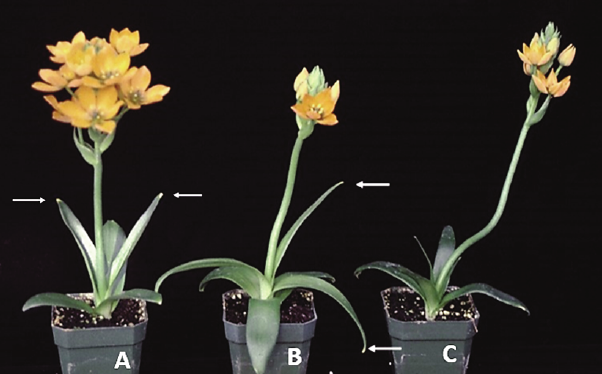
Fig. 2 ­ Patterns of scape growth of O. dubium . A) straight growth and no bending of the scape (score 1). B) leaning to sideway without bending at the base of scape (score 2). C) scape at the base started to grow at about 30­ degree angle, and continue to grow leaning to sideway (score 3). Incipient leaf tip burn (LTB) symptoms are indi­ cated with arrow sign. Plant A is considered the most ideal and high­quality plant.